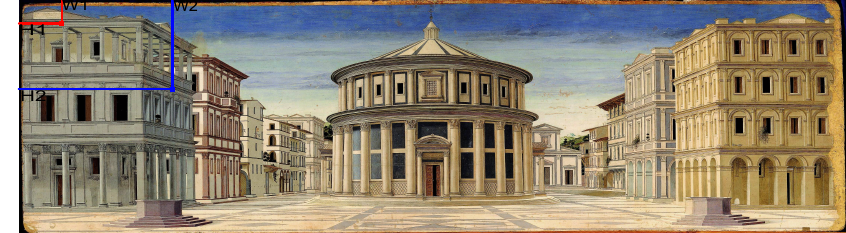
Figure 4. An example of the pixel consideration. Here the pixel dimension is increased for a better